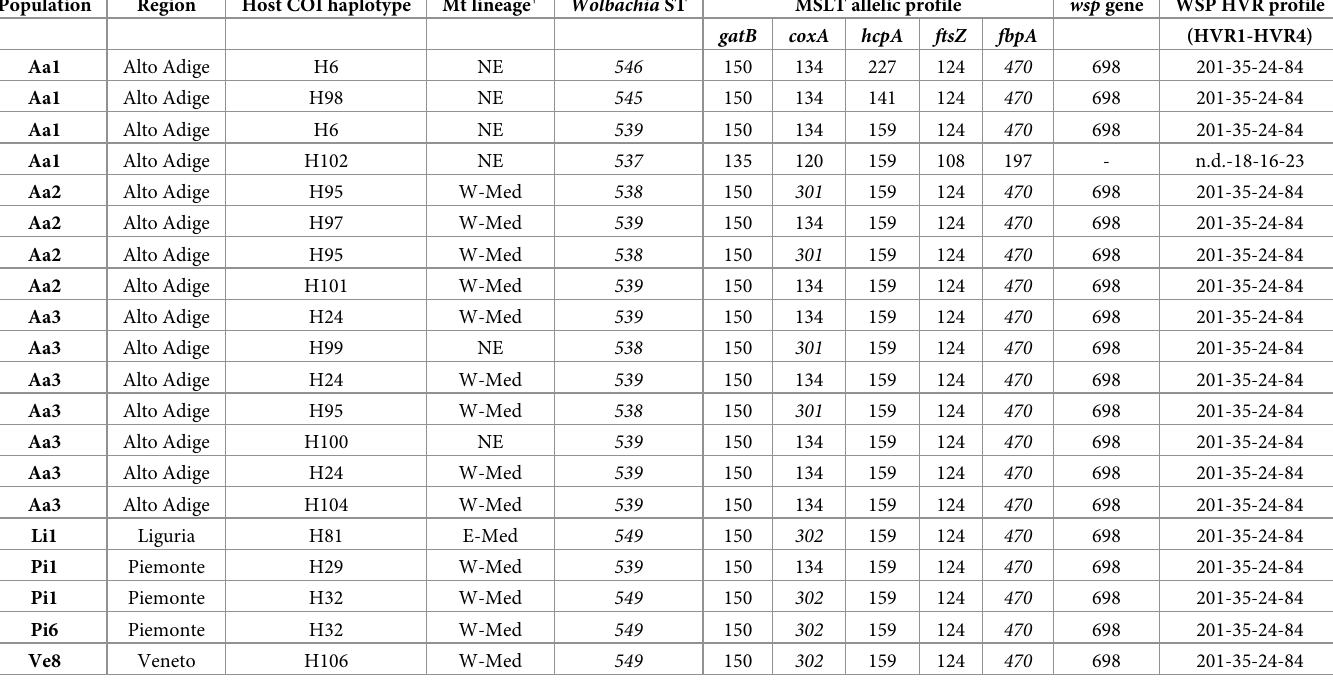
Table 3. Wolbachia sequence types (ST) in Philaenus spumarius and their association with host population and haplotype. New STs and allelic variants in the MLST database are in italic.